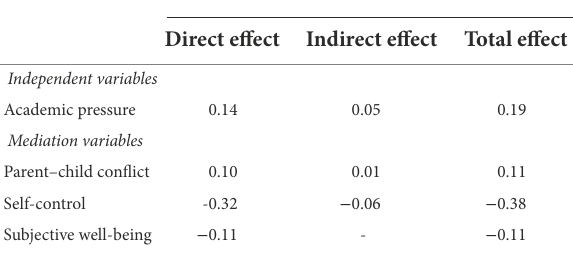
TABLE 5 Direct and indirect effects of academic pressure and problem behavior in